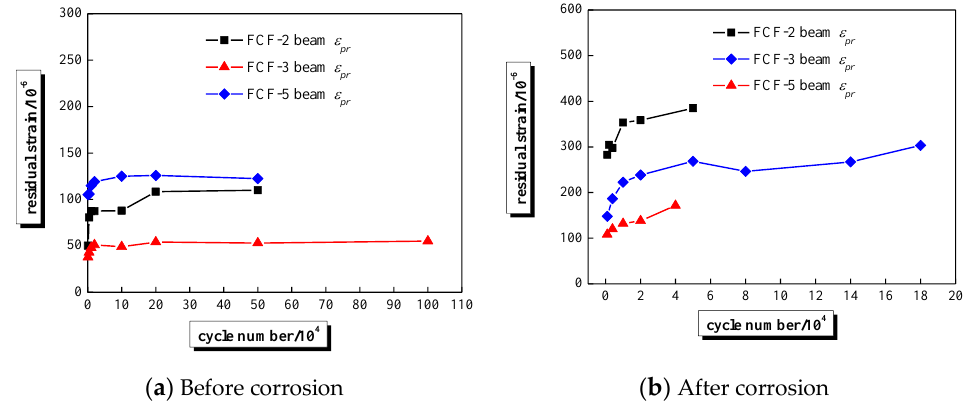
Figure 10. The residual strain-load cycle number curves of steel strands.